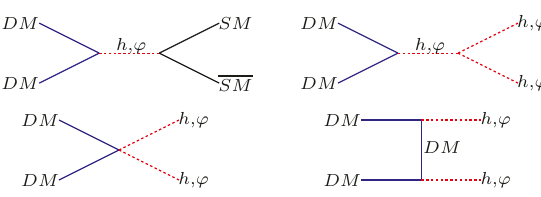
Figure 1. Pair annihilation processes for both scalar and vectorial DM components.